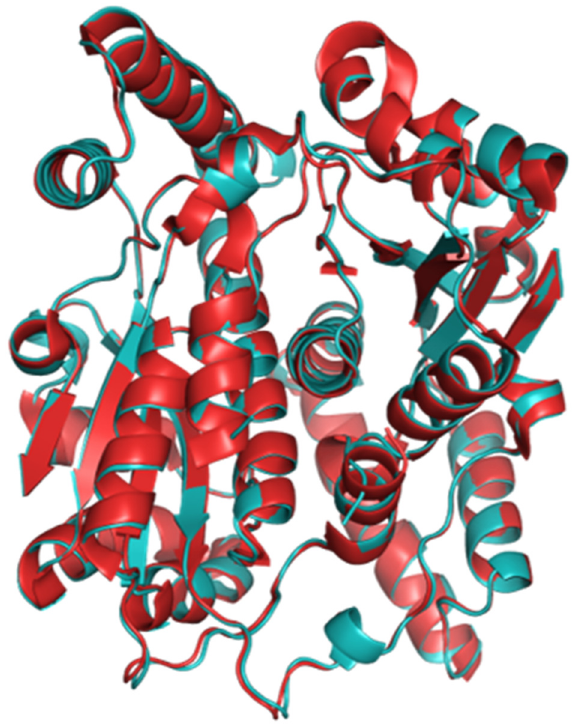
Figure 3. Cartoon overlay of the structures of NTR 2.0 and parental V. vulnificus NfsB. The parental enzyme is depicted in red and NTR 2.0 in cyan.